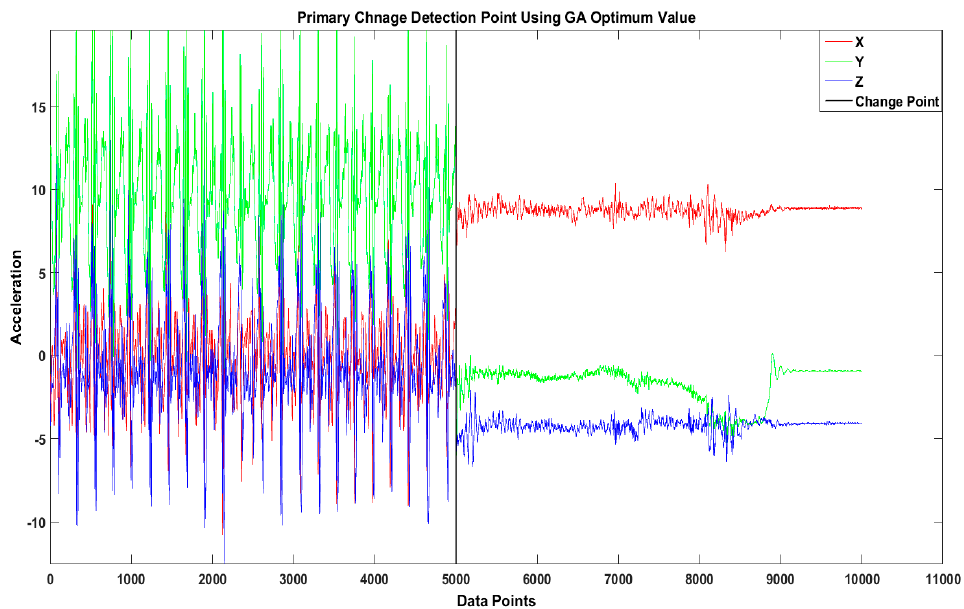
Figure 3. Real dataset example of sliding window change-detection result for the activity “walking to running”.